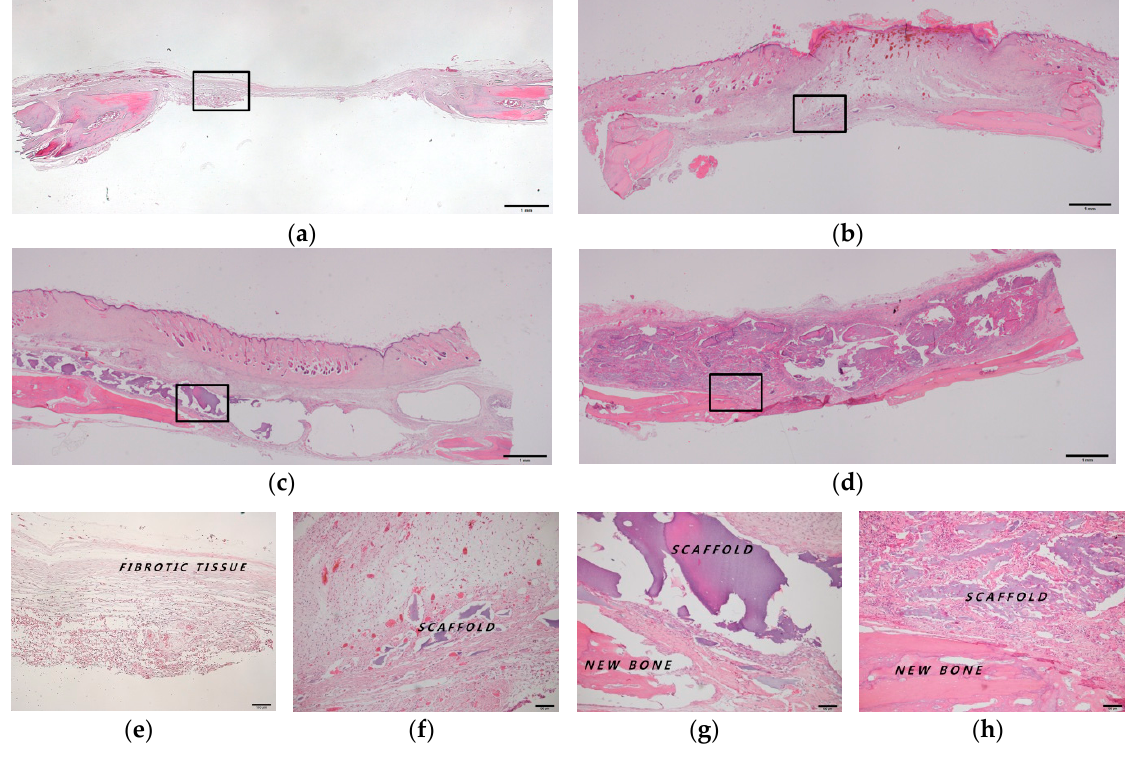
Figure 4. Histological images (hematoxylin and eosin staining) at four weeks after operation. ( a ) unfilled defects from the control group (bar = 1 mm); ( b ) AL (bar = 1 mm); ( c ) AL/HA (bar = 1 mm); and ( d ) AL/HA/SF (bar = 1 mm) beads; ( e – h ) magnified views of the boxed areas in ( a – d ) (original magnification 100×, bar = 100 µm).